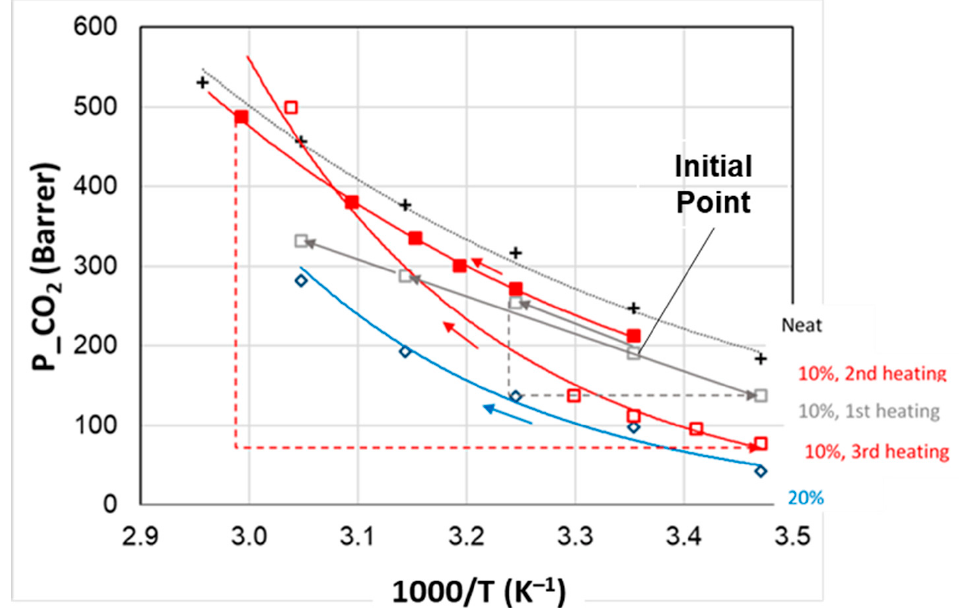
Figure 14. CO 2 permeability measured during heating ramps in Rnew–10% IL1 composite membrane compared to neat Rnew and Rnew–20% IL2 composite membrane. Lines are the exponential fit of the experimental points.